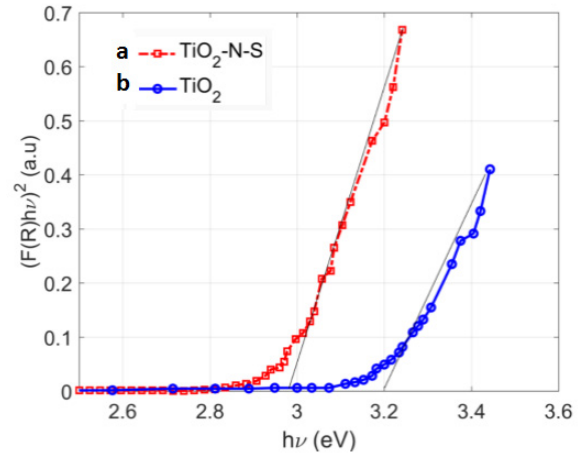
Figure 5. DRS analysis a: TiO